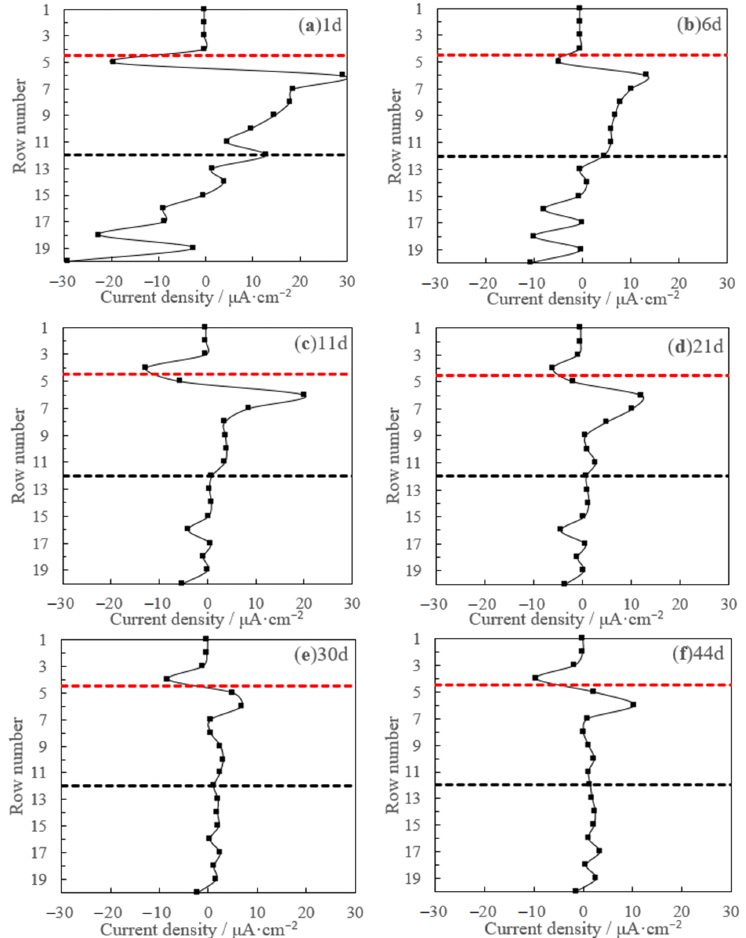
Figure 3. Single row current density vector sum at various experiment times. ( a – f ) correspond to 1, 6, 11, 21, 30, and 44 days, respectively. In the initial stage of the dual corrosion cell, the place near the seawater/atmosphere interface was cathode current, the seawater area was anode current, and the sea mud area was the coexistence region of cathode current and anode current (as shown in Figure 3a,b). On the 11th day, the 4th row electrode in the atmospheric area showed obvious cathode current, while the current distribution on the surface of the electrode in the seawater area did not change. The maximum single cathode current was 12.8 µA·cm − 2 in the 6th row and the maximum single anode current was 20.19 µA·cm − 2 in the 6th row. A thin liquid film formed on the electrode surface in the atmosphere area, which participated in the whole electrode reaction process and became the strongest cathode reaction region [23]. As oxygen was continuously consumed in the sea mud area, the electrode in the 15th row, 17th row and 19th row in the sea mud area was reversed to the anode current. On the 21st day, the cathode current continued to expand upward in the atmosphere, and the third electrode in the atmosphere area showed a weak cathode current. In the coupling stage of the dual corrosion cell, the place near the seawater/atmosphere interface was cathode current, the seawater area was anode current, and the sea mud area was the coexistence region of cathode current and anode current (as shown in Figure 3c,d). Compared with the initial stage, the cathode reaction was the strongest in the atmosphere area due to the production of thin liquid film on the electrode surface [25]. The cathode current in the sea mud area decreased gradually and the polarity reversed From the 30th day until the end of the experiment, the place near the seawater/atmosphere interface was cathode current, the seawater area was anode current, and the sea mud area (except for the 20th row) was the anode current (as shown in Figure 3e,f). The dual corrosion cell had transitioned to a single corrosion cell. Figure 4 shows the variation of the total anode current density on the electrode surface with the immersion time. The anode current density on the electrode surface was maintained at the maximum